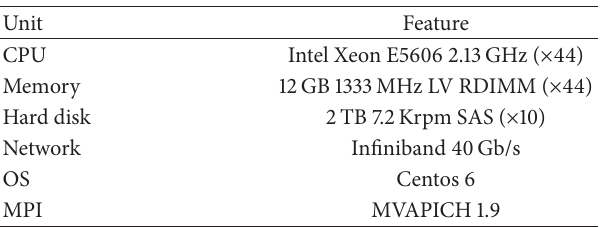
Table 2: Technical